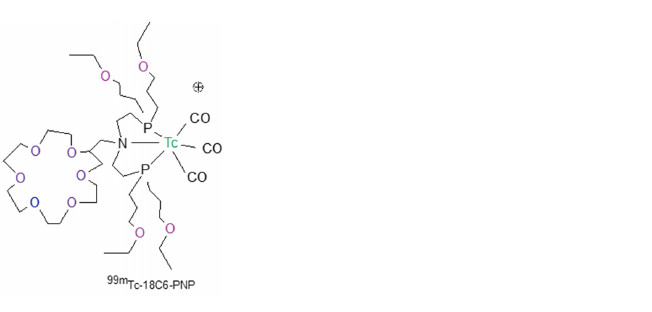
( b ) Figure 5 . Chemical structure fac -[ 99m Tc][Tc(CO) 3 {HC[3,4,5-(CH 3 OCH 2 ) 3 pz] 3 }] + ( a ) and biodistribution 99m Tc][Tc(CO) data in rats compared to [ 99m Tc]Tc-Sestamibi ( b ) [59]. Figure 5. Chemical structure fac -[ 3 {HC[3,4,5-(CH 3 OCH 2 ) 3 pz] 3 }] tion data in rats compared to [ 99m Tc]Tc-Sestamibi ( b )